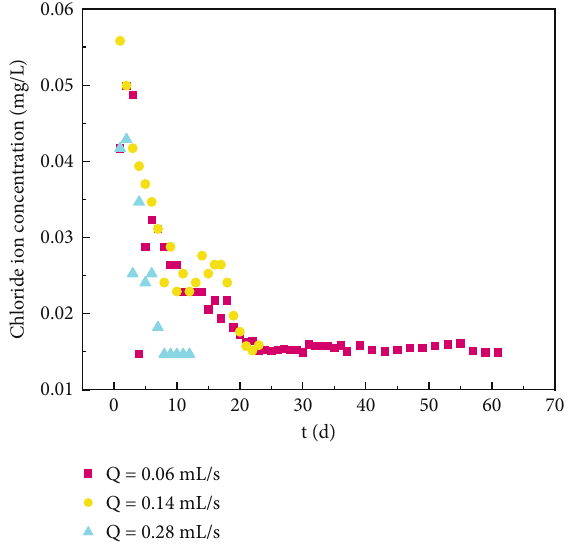
Figure 16: Scatter plot of chloride ion concentration change.